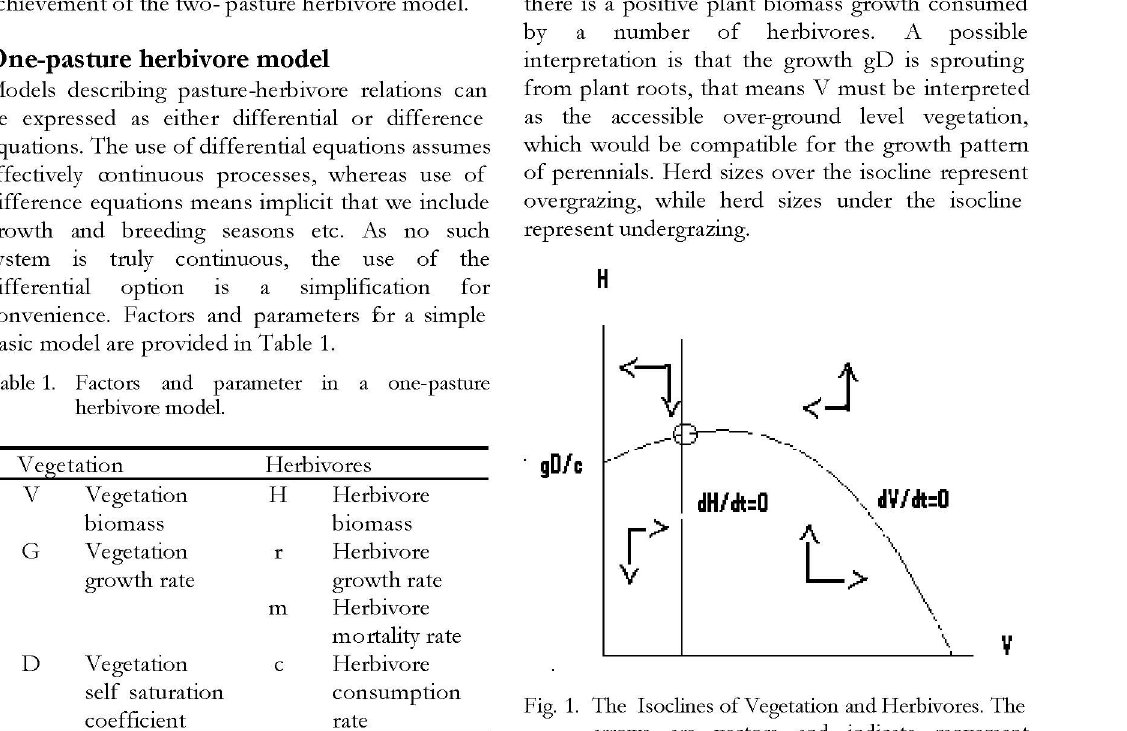
Fig. 1. The Isoclines of Vegetation and Herbivores. The arrows are vectors and indicate movement